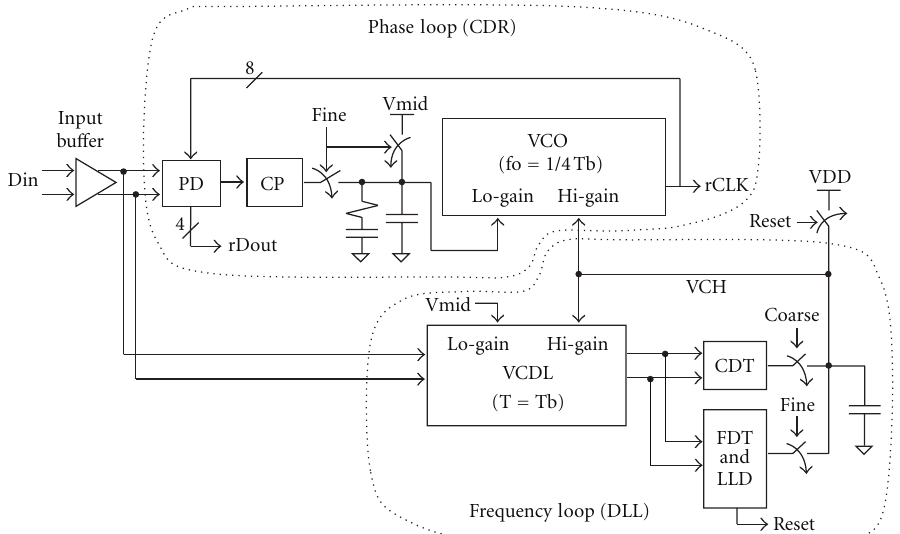
Figure 1: Architecture of proposed CDR.